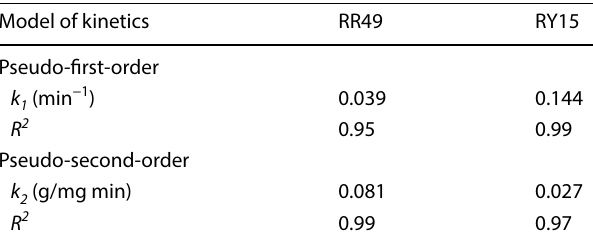
Table 4 The kinetic studied models used for RR49 and RY15 removal Model of kinetics RR49